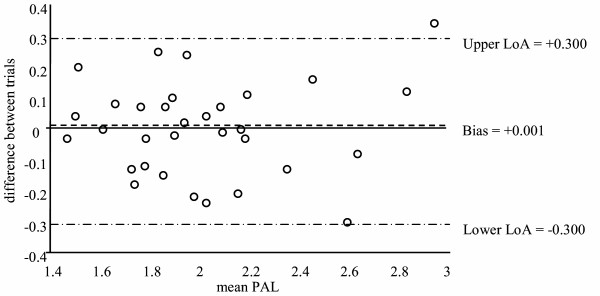
Bland-Altman plot (bias and limits of agreement) for the test-retest values for physical activity level (PAL) when the MARCA was administered twice (285 min apart) during one day. Note: LoA = limits of agreement, PAL = physical activity level (a weighted mean MET.d-1 score)